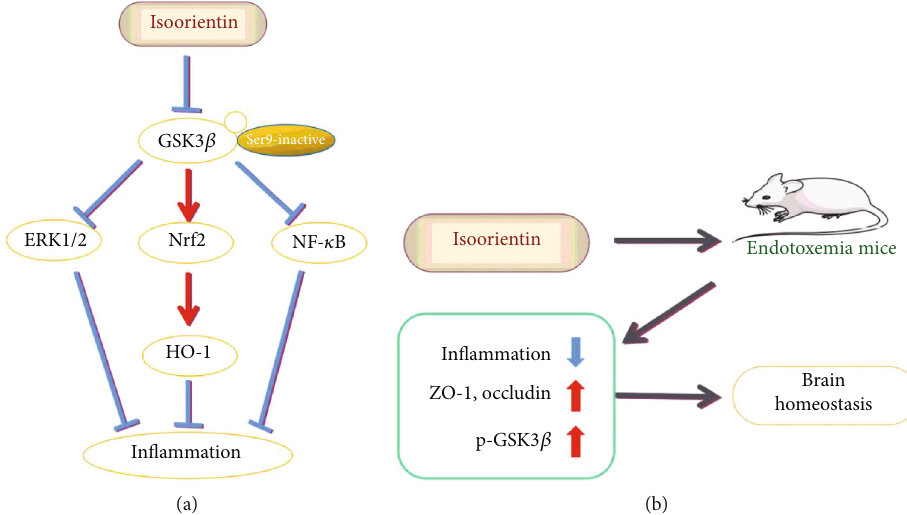
Figure 6: Proposed mechanism of isoorientin inhibiting in fl ammation in the monocyte macrophage RAW264.7 cells (a) and endotoxemia mice (b) via GSK3 β